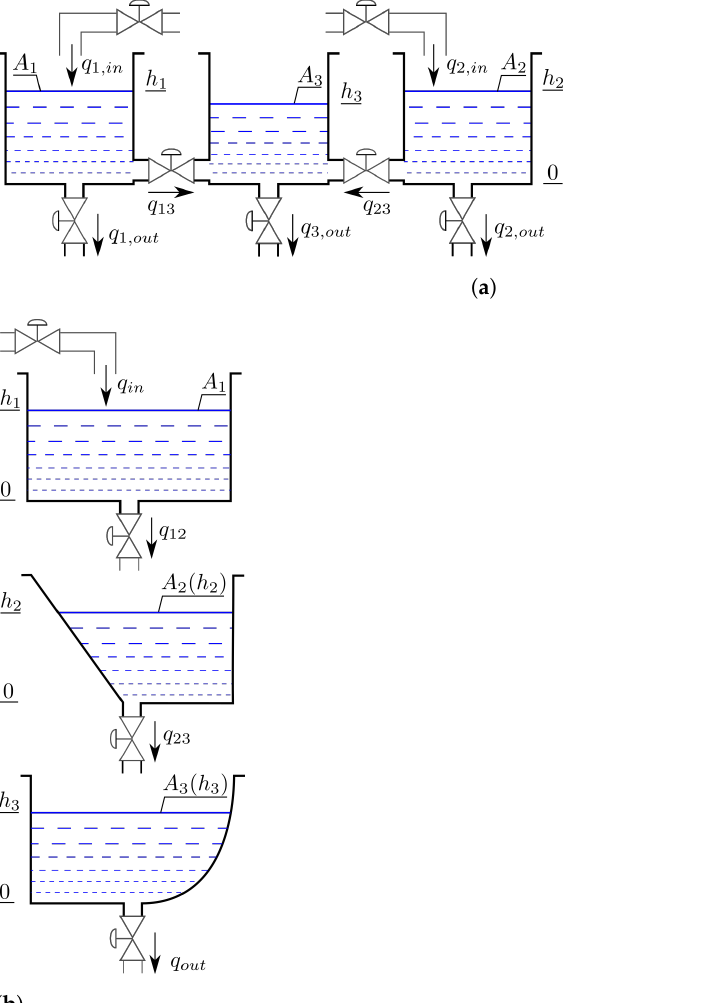
Figure 4. A physical model of the three-tank system. ( a ) Coupled configuration with two control inlets and two outlets, see [14,15]. ( b ) Cascaded tanks with one control inlet and outlet with varying geometry, see